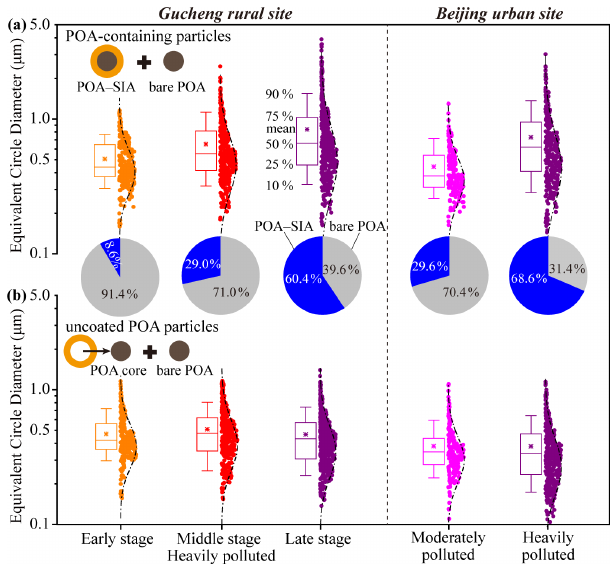
Figure 7. Box plots showing equivalent circle diameters (ECDs) of (a) POA-containing particles (including core–shell POA–SIA and bare POA) and (b) uncoated POA particles (including POA cores without SIA shell and bare POA) in different polluted periods at the Gucheng rural site and Beijing urban site. The solid circles (right of the boxes) represent the ECDs of individual particles with lognor- mal distributions. The pie charts present the relative number frac- tions between POA–SIA and bare POA particles in different pol- luted